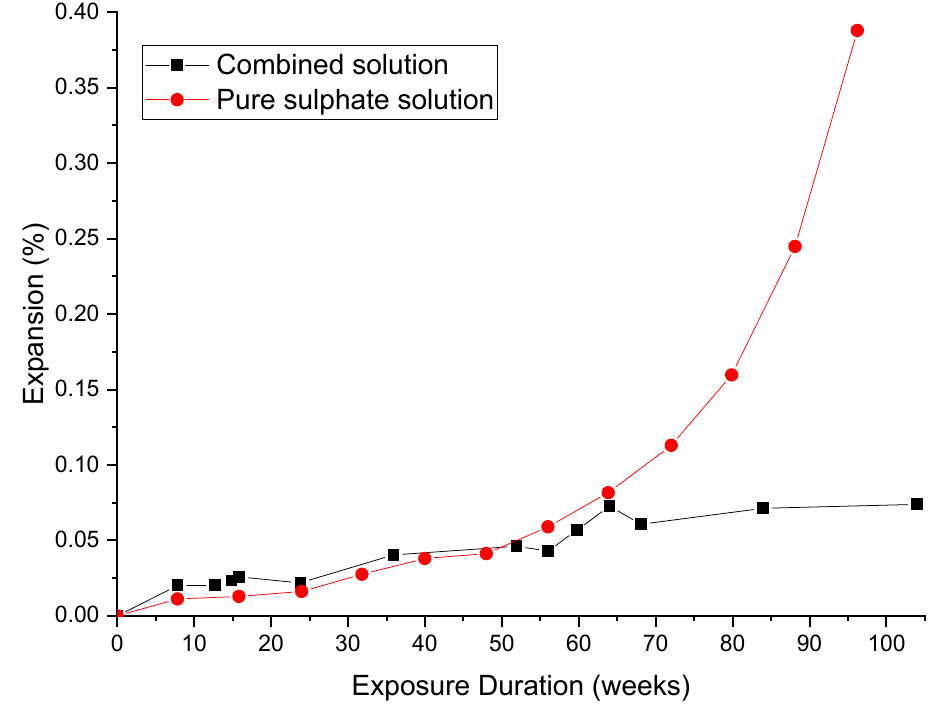
Figure 6. Comparison between expansion of CEM I mortar prisms exposed to pure sulphate [137] and combined chloride–sulphate solution [15].